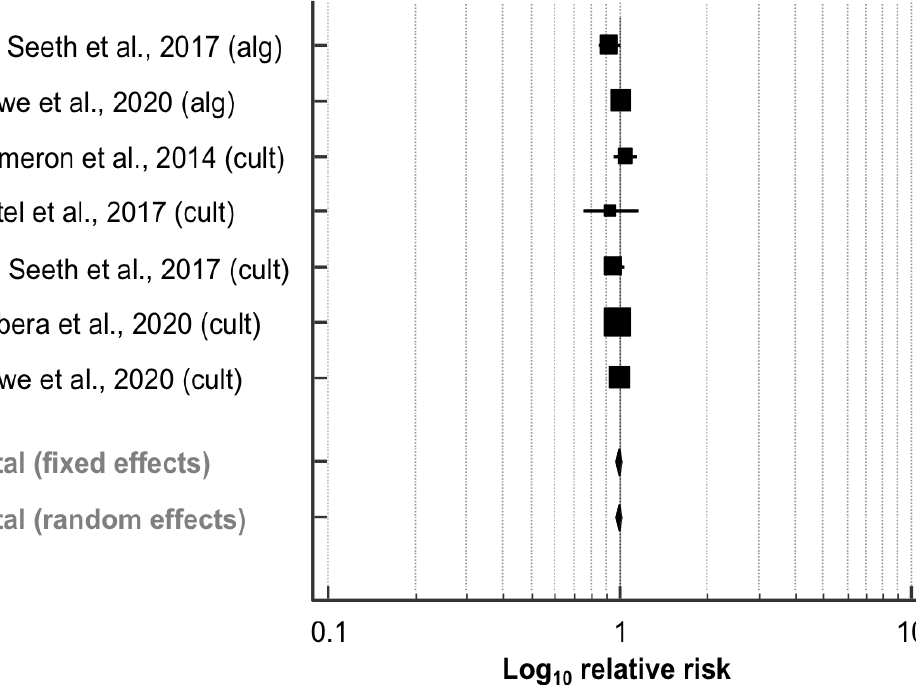
Figure 5. Effect of algorithm-guided (alg) and culture-based (cult) selective dry cow treatment (experimental group) compared to blanket dry cow treatment (control group) on the cure risk during the dry period. See Figure 3 for remainder of key.